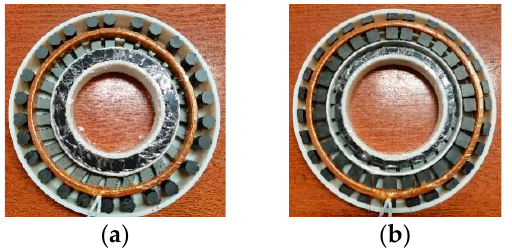
Figure 12. Magnetically coupled structure: ( a ) U-shaped; ( b ) E-shaped.